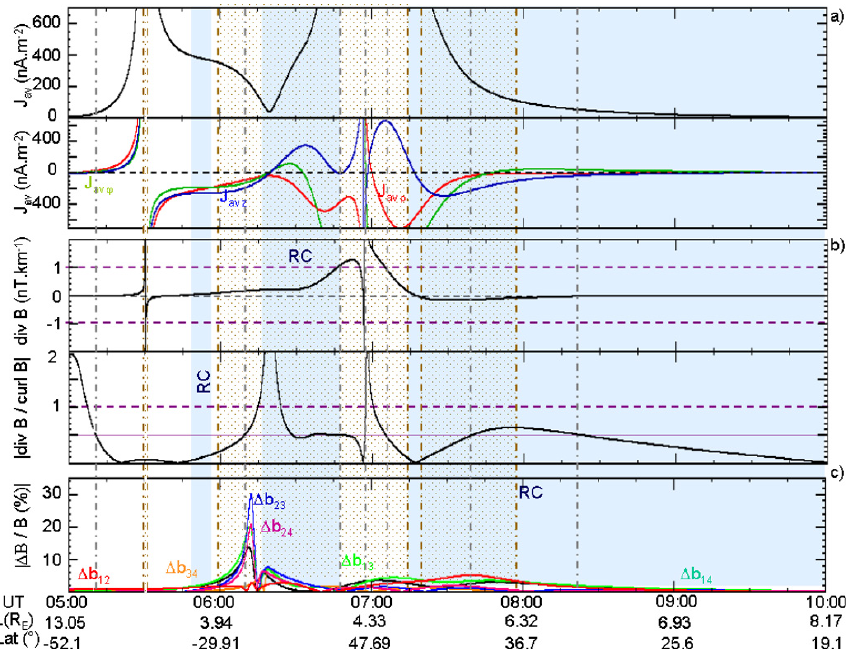
Fig. 9. Same as Fig. 6, but using a magnetic field calculated by subtracting a dipolar magnetic field from the Tsyganenko one. The grey dotted-dashed lines indicate the times when div B (cid:14) curlB =